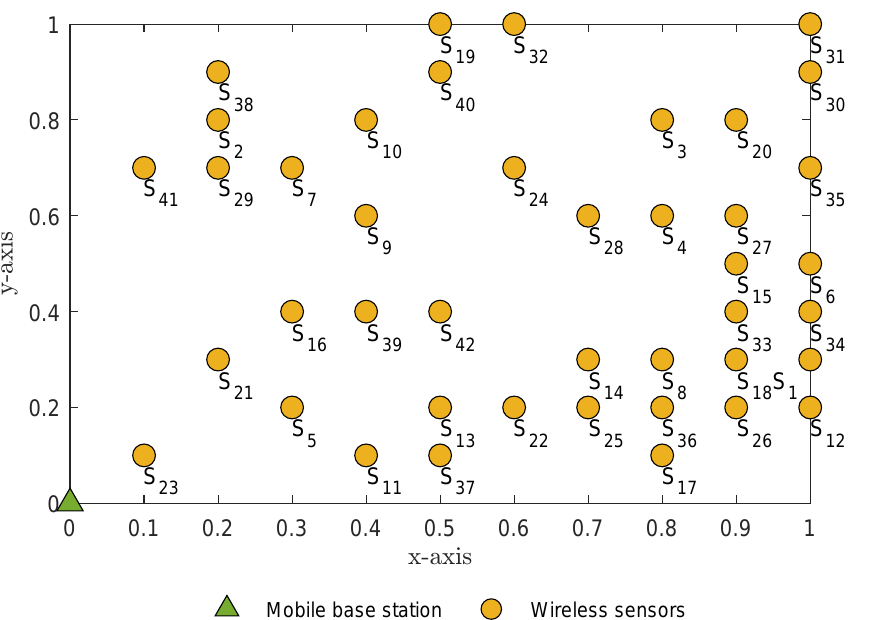
Figure 1. Random positioning of sensor nodes, where 20 ≤ N ≤ 50. Table 2. Wireless sensor positions are distributed randomly. Sensors x -Coordinate y